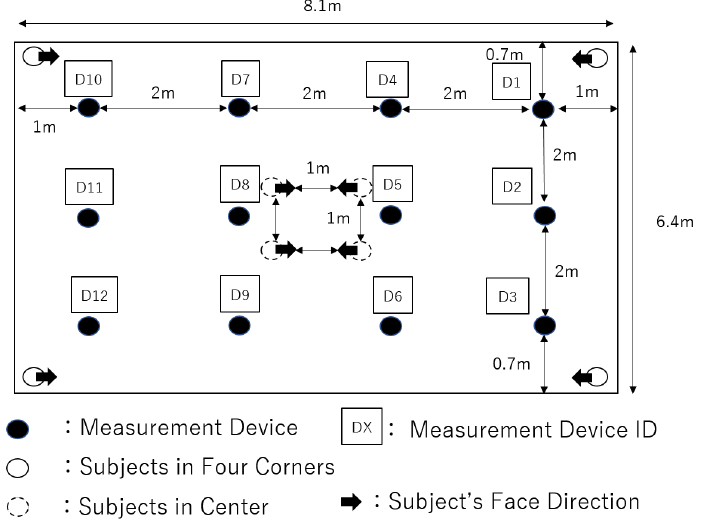
Figure 5. Position of subjects and measurement devices in Case 3a and Case